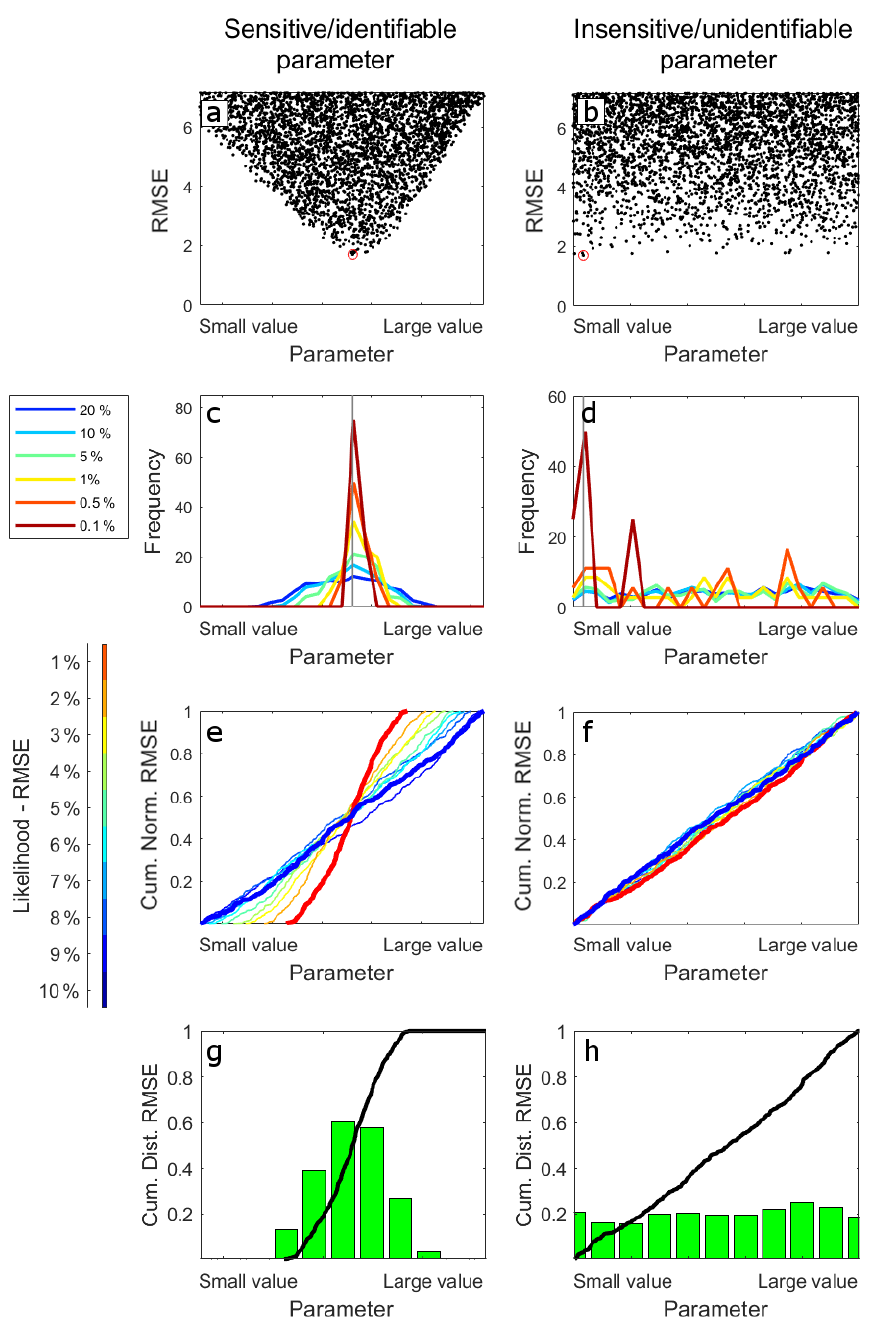
Figure A1. Examples of the four types of visualizations intended for parameter identifiability and sensitivity, with the plots in the first column (a, c, e, g) reporting an example of plots for sensitive and identifiable parameters and plots in the second column (b, d, f, h) reporting an example of plots for an insensitive and non-identifiable parameter. (a, b) Parameter vs. likelihood plots. (c, d) Parameter distribution plots for the top 20%, 10%, 5%, 1%, and 0.1% of the results. (e, f) Regional sensitivity analysis plots from the top 1% to the top 10% of the results. (g, h) Identifiability plots for the top 1% of the model